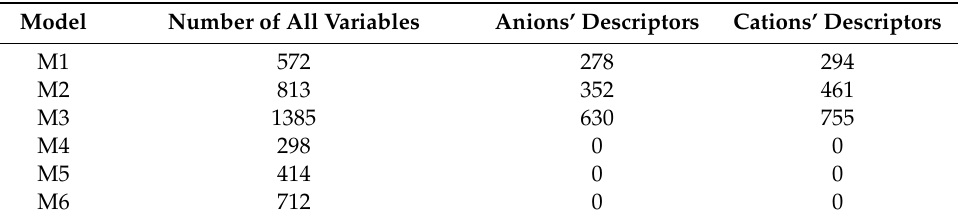
Table 2. Number of individual variables in investigated data